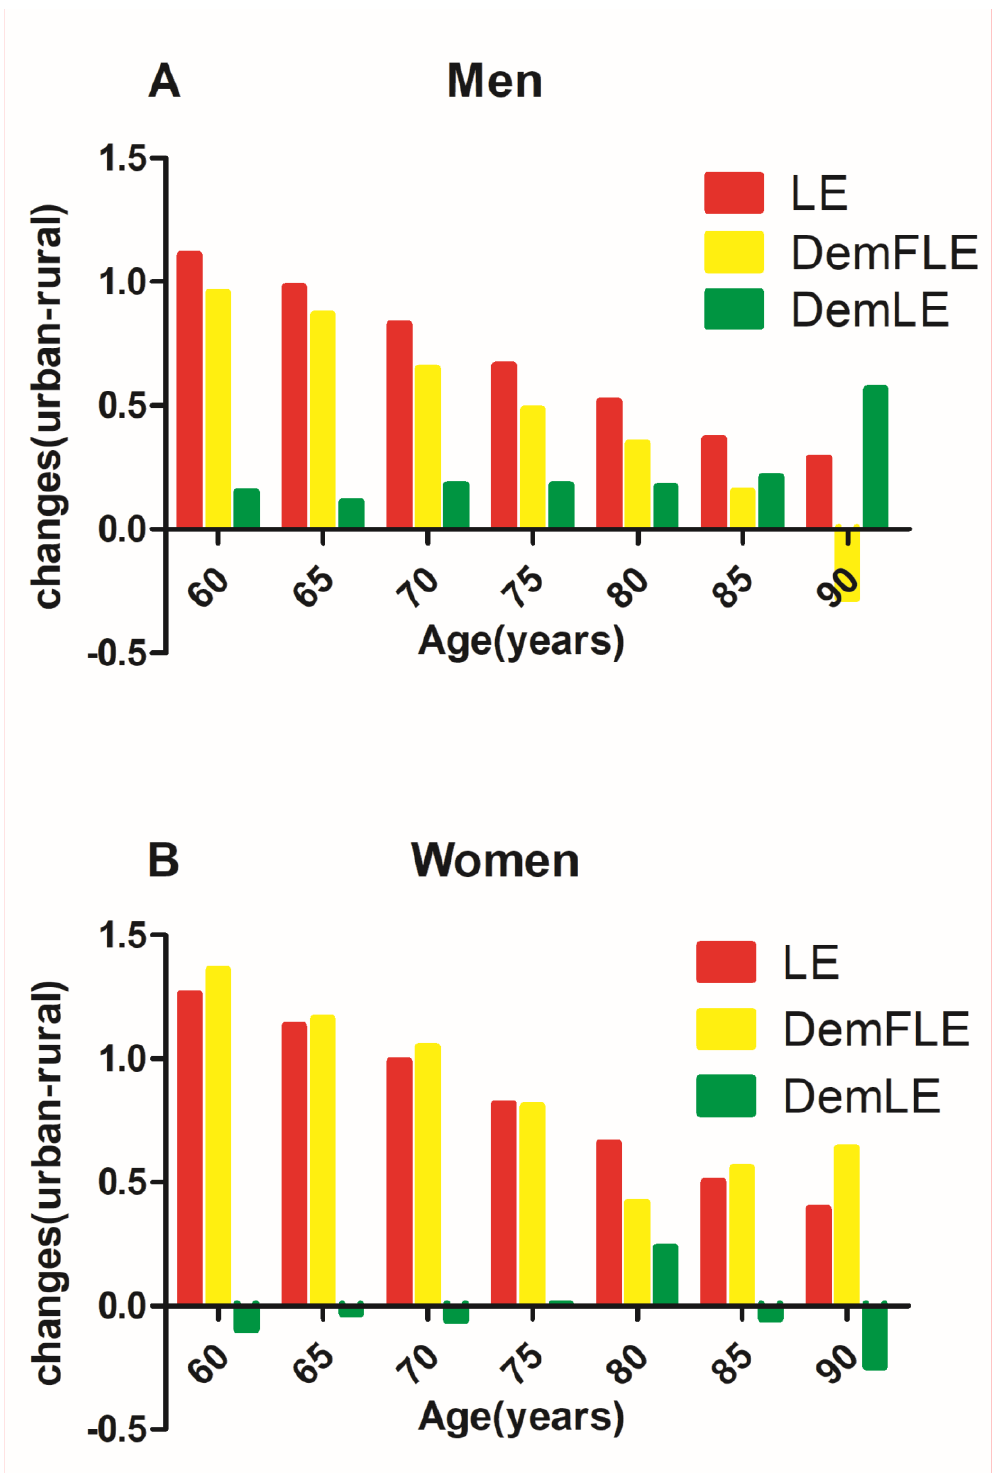
Figure 4. Absolute changes in life expectancy (LE) and dementia-free life expectancy (DemFLE) between urban and rural areas for men and women. A. Men B. Women.